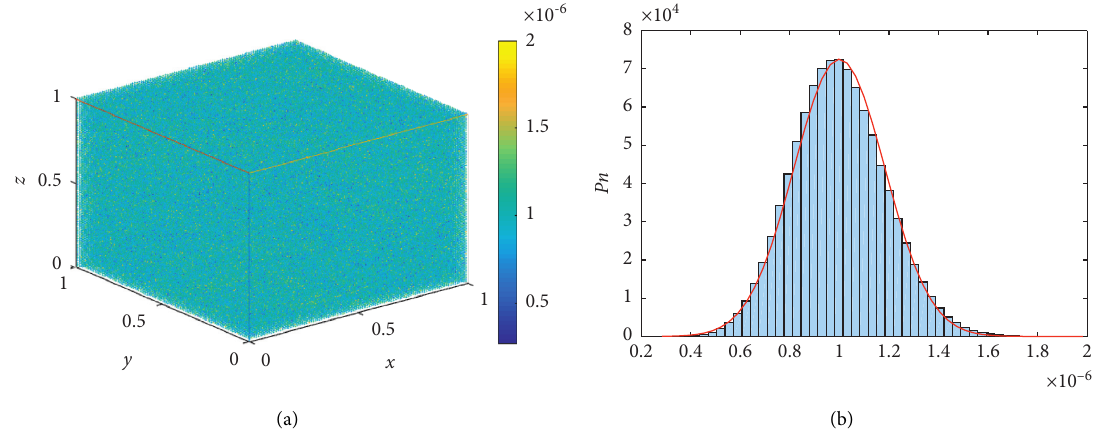
Figure 6: (a) The approximate density function P 􏽢 n of 3D-PHM. (b) The histogram of the density, where n � 100 and 􏽢 n � 30 × n 3